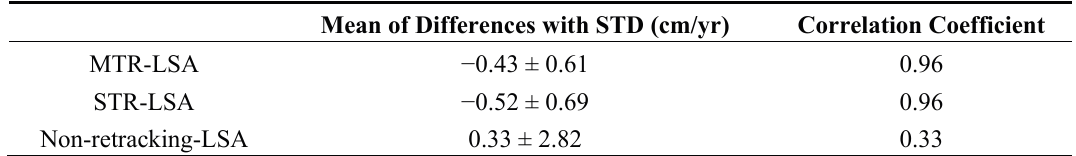
Table 3. Mean differences and correlation coefficients between the vertical motion trends derived from leveling and retracked altimetry in the nine study